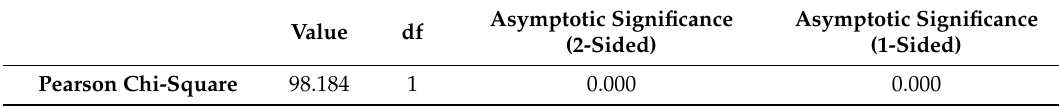
Table 6. Chi-square test for di ff erence in proportions of heat stress (T h ) occurrence during peak sun.